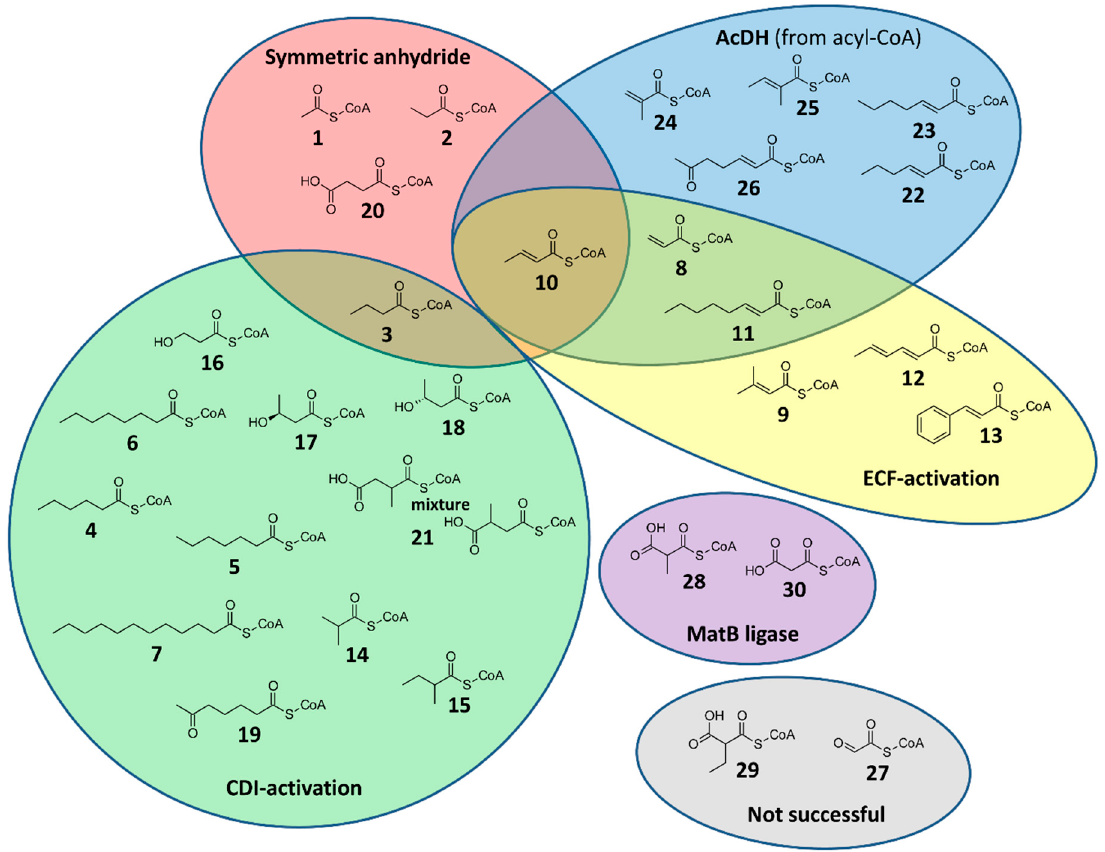
Figure 1. Acyl-CoA thioesters that were successfully synthesized by one of the five different methods tested in this study. Color code: symmetric anhydride method, red; CDI-activation, green; ECF-activation, yellow; acyl-CoA-desaturation by AcDHs, blue; ATP dependent ligation by MatB, purple. Note that not all methods were tested with every substrate.